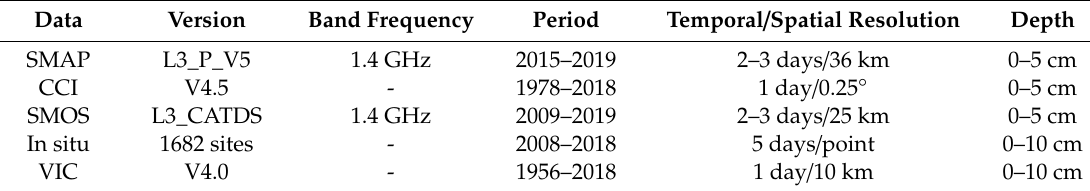
Table 1. Summary of satellite, in situ, model soil moisture products used in this